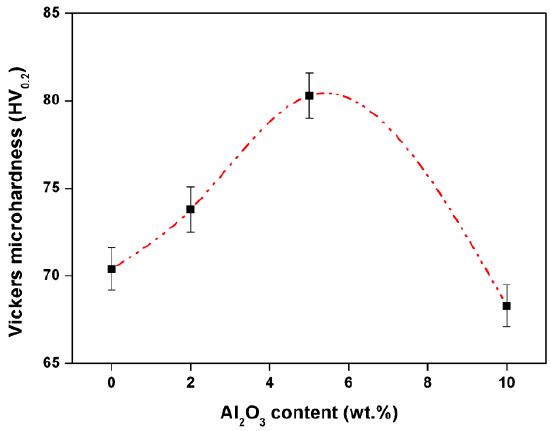
Figure 4. Vickers hardness measurements of Al-12Si/Al 2 O 3 nanocomposites produced by the hot extrusion method.